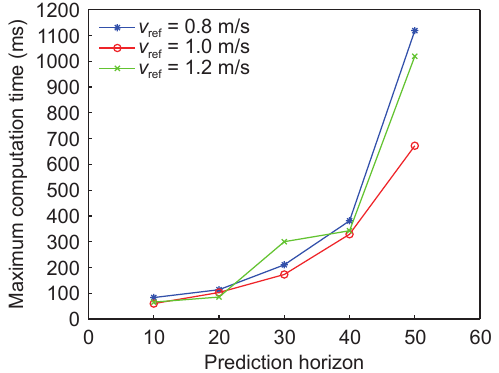
Fig. 10 Maximal computation time under different v N .